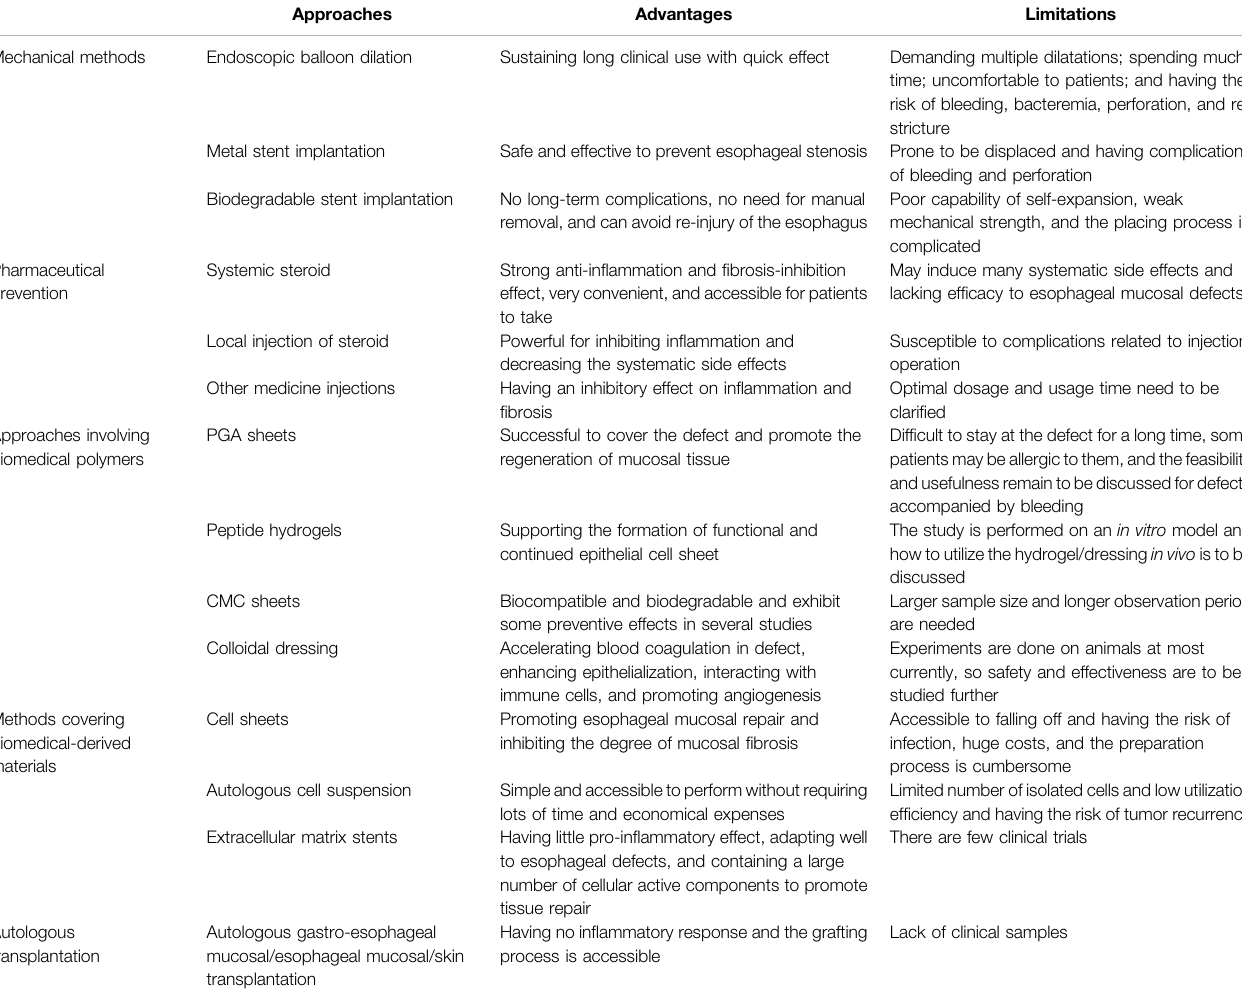
TABLE 1 | The advantages and limitations of strategies having been reported to prevent esophageal stricture after